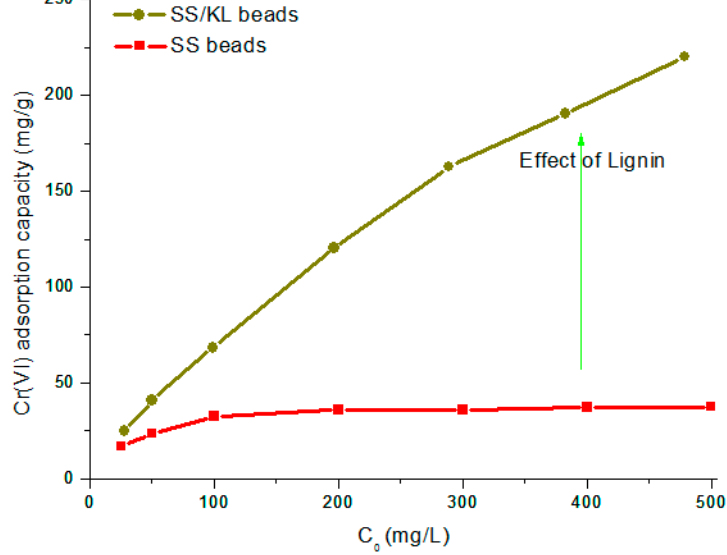
Figure 9. Effect of initial Cr(VI) concentration on the equilibrium Cr(VI) ion biosorption capacities of SS and SS/KL blend beads (adsorbent dose: 1.0 g/L, temperature: 25 °C, agitation rate: 180 rpm).